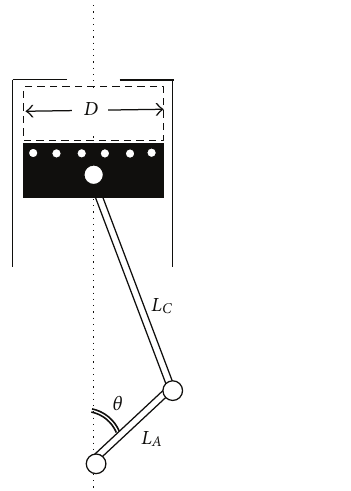
model is R , the ratio of the connecting rod length L C to the crank arm radius L A